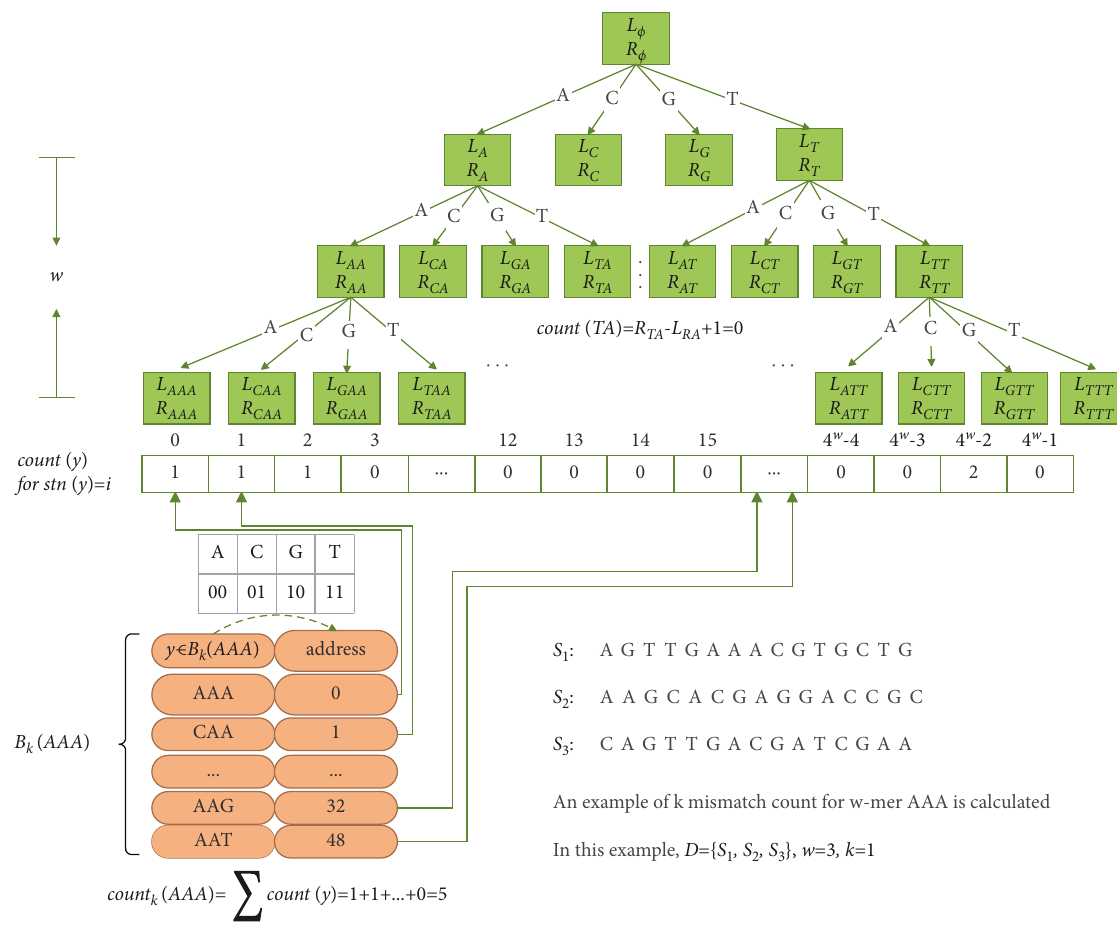
Figure 1: Schematic diagram of k-mismatch